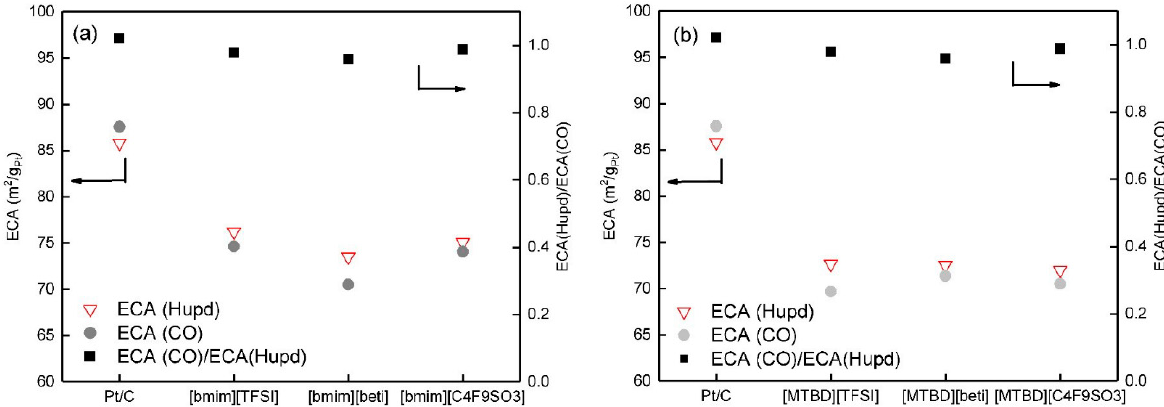
Figure 5. Comparison of electrochemical surface area of ( a ) [bmim] + ILs and ( b ) [MTBD] + ILs measured by CO stripping ECA(CO) and by hydrogen underpotential adsorption ECA(H upd ). The right y-axis shows the ratio of ECA(H upd )/ECA(CO).